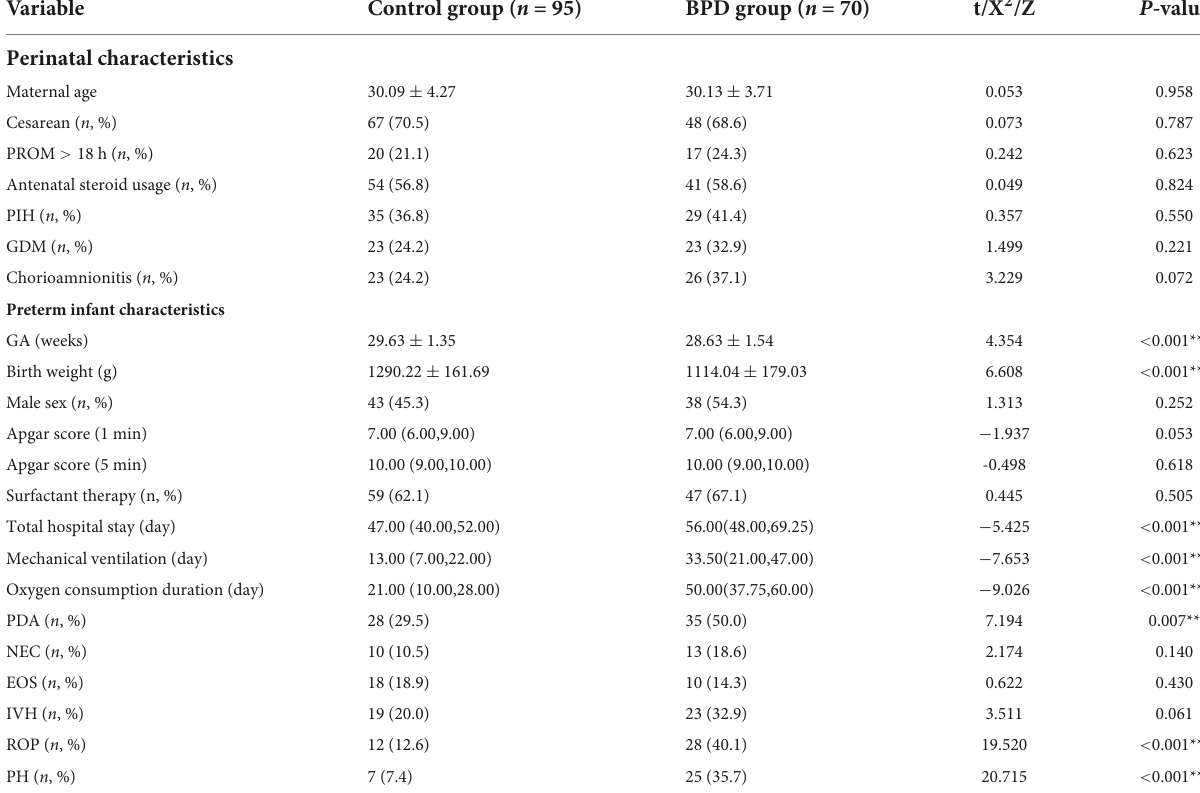
TABLE 1 Perinatal and preterm infant characteristics.